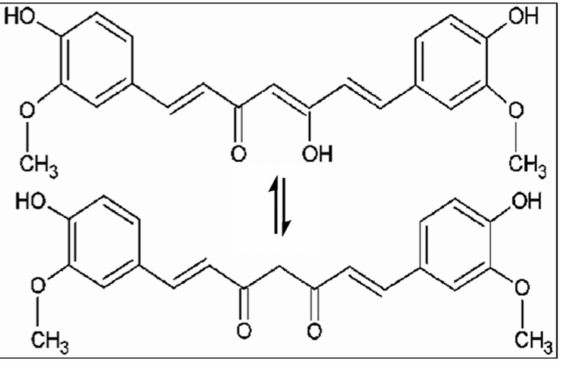
Figure 1. Chemical structures of